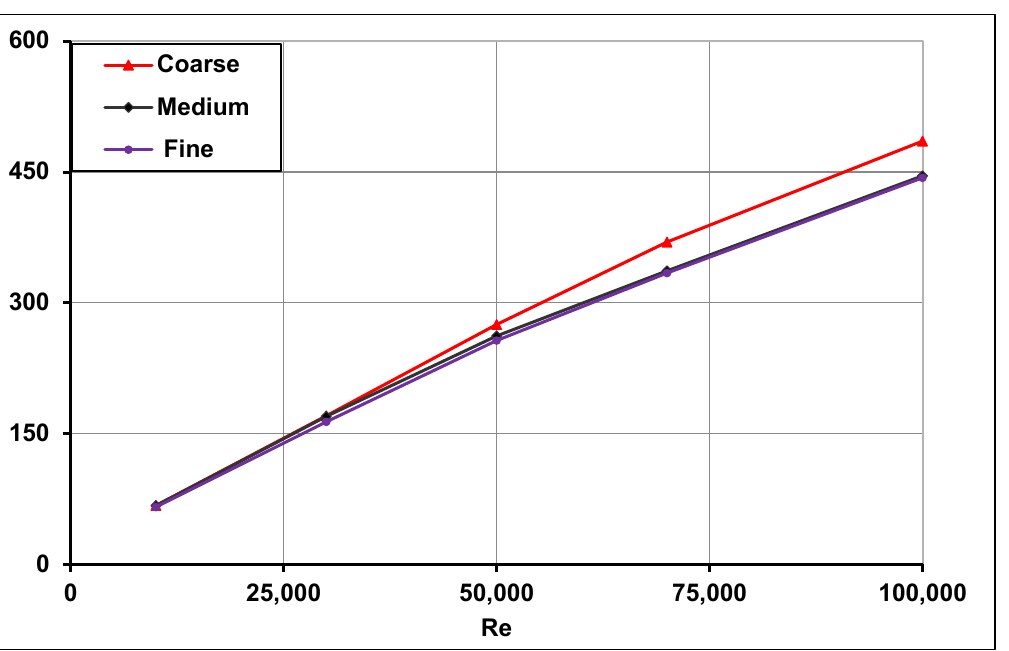
Figure 7. Mesh independence study for the solar receiver with a single straight conical strip insert. 3.2. Numerical Model Validation The numerical results of a typical receiver are validated and compared with ex- perimental and empirical correlations using two turbulence models—the 𝐿𝐿𝐿𝐿 𝑘𝑘 − 𝜀𝜀 model derived by Launder and Sharma [74] and the 𝑘𝑘 − 𝜔𝜔 𝐿𝐿𝐿𝐿𝑇𝑇 model proposed by Menter [73]. The mean Nusselt numbers, determined from the numerical results, were validated with the empirical correlation proposed by Gnielinski [46]. Water was used as the working fluid, with an inlet temperature of 320 K and a constant Prandtl ( 𝑃𝑃𝑃𝑃 ) value of 3.77. The 𝑘𝑘 − 𝜔𝜔 𝐿𝐿𝐿𝐿𝑇𝑇 model was found to be more accurate as it determined the Nusselt number